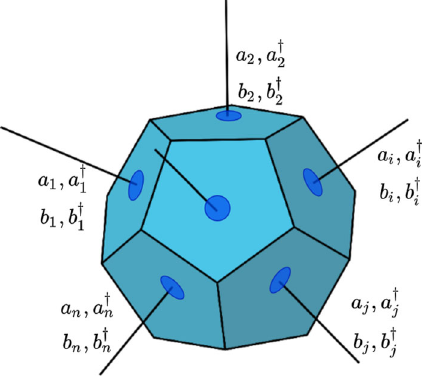
Fig. 5 Applying the Schwinger boson trick to each spin label on all the edges operators a , a † , b , b † in terms of which the su ( 2 )